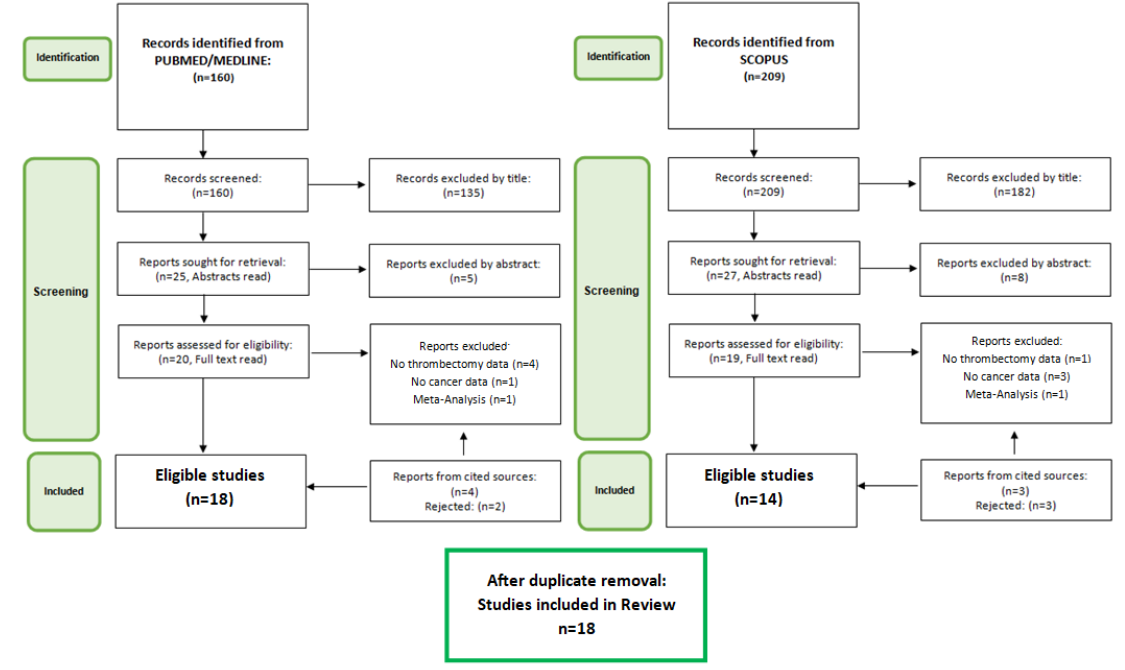
Figure 1. Literature search flowchart.